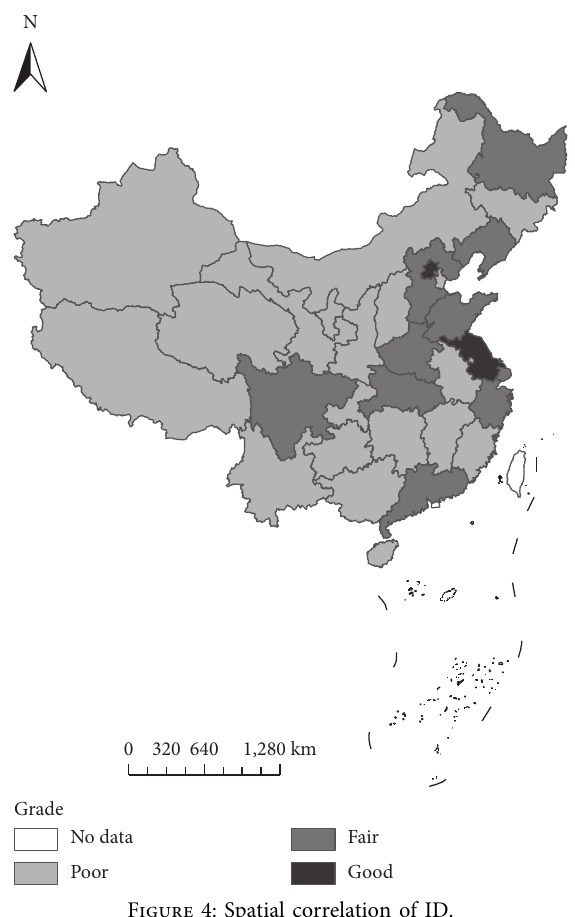
Figure 4: Spatial correlation of